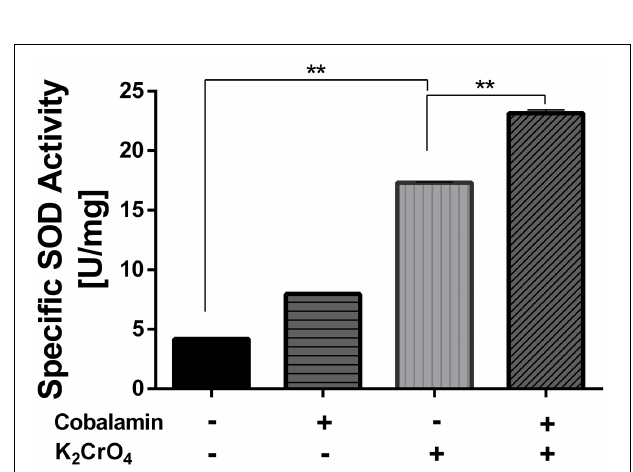
FIGURE 4 | Effect of cobalamin on CcP activity. The activity was followed spectrophotometrically at 550 nm as indicated under Section “Materials and Methods.” Data represent the average of two independent experiments (lines on top of bars indicate value ranges). One unit (U) is defined as the amount of enzyme required to oxidize 1 µ mol of ferrocytochrome c per min. ∗ P < 0.05, ∗∗ P < 0.01.